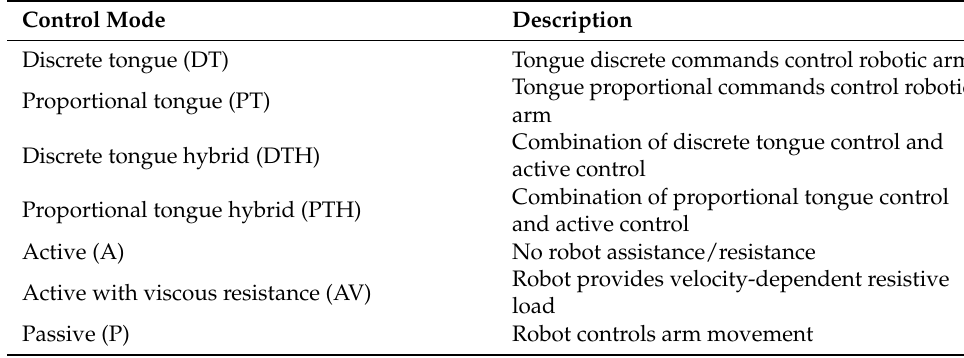
Table 1. The TDS-KA system control modes.